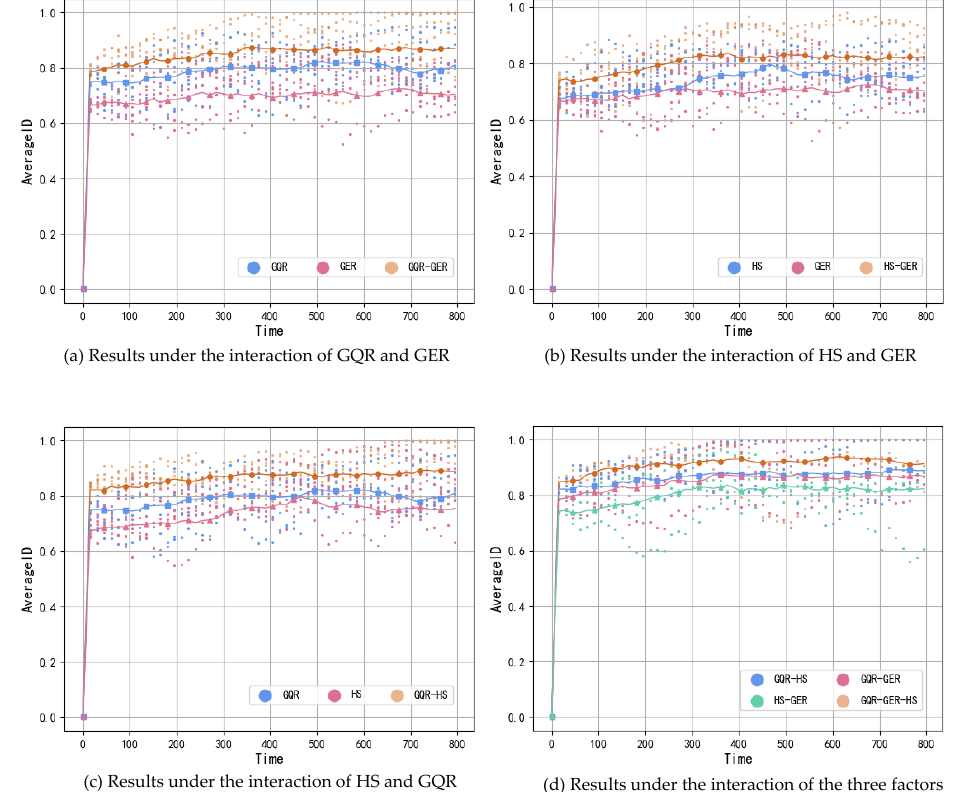
Figure 4. Output diagram of average intention results in a multifactor